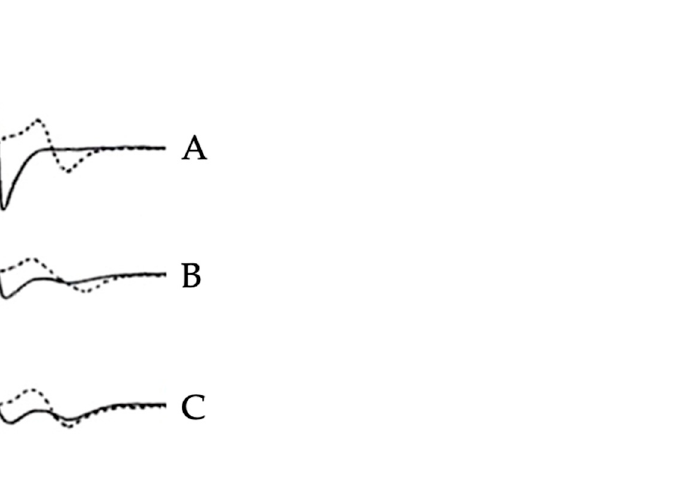
Figure 3. EPR spectra of 5-doxylstearic acid (5.5 × 10 − 5 M) in oriented lipid films—of 5.5 × 10 − 3 M phospholipids concentration, with a composition of 40 mol% PC, 35 mol% PE, 20 mol% CL, 3 mol% PI and 2 mol% PS—at the applied magnetic field parallel (broken line) and perpendicular (solid line) to the film’s normal in the absence of alcohols and melittin ( A ) and in the presence of 5.5 × 10 − 5 M melittin ( B ) and 5.5 × 10 − 5 M melittin and 5.5 × 10 − 4 M ethanol ( C ).